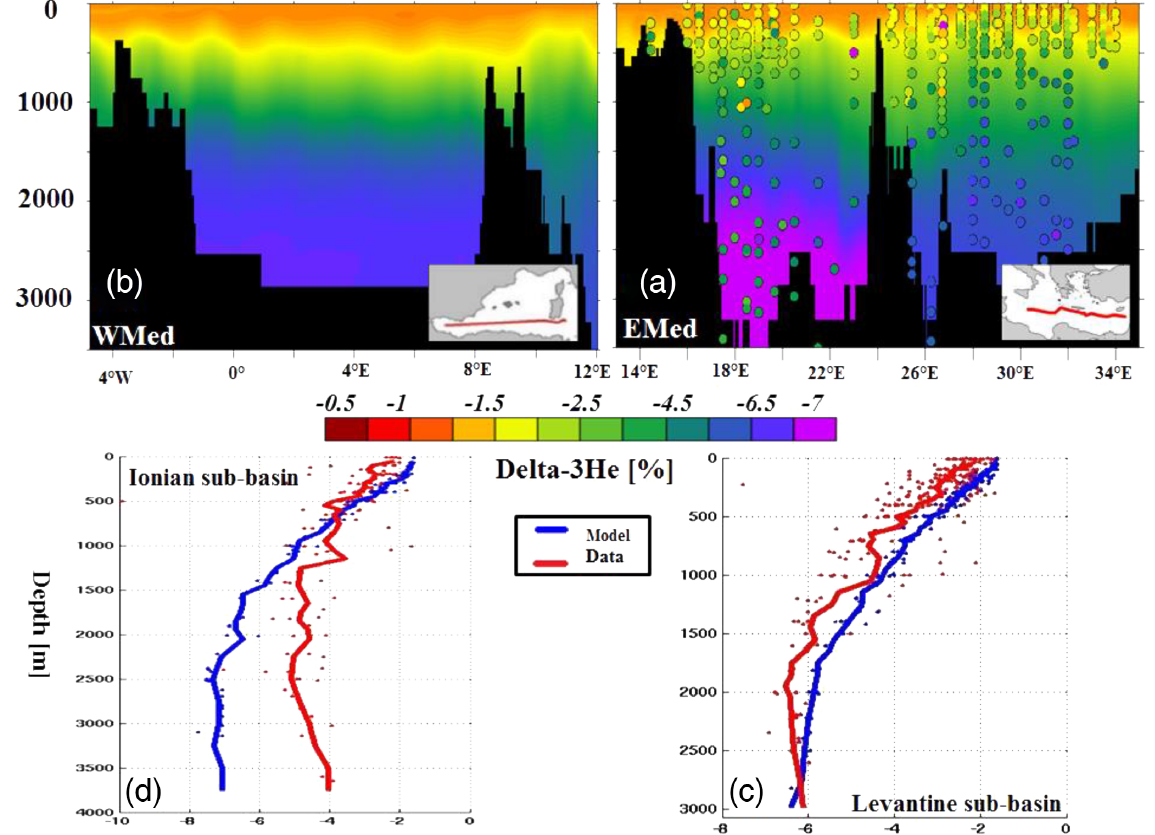
Figure 4. Crustal+atmospheric δ 3 He (in %) model–data comparison along the Meteor M5 (September 1987) section: (a) Colour-filled contours indicate simulated δ 3 He (%), whereas colour-filled dots represent the crustal + atmospheric δ 3 He deduced from in situ observations using the component separation method of Roether et al. (1998) in the eastern basin (see Sect. 4 for details). (b) : same as (a) , but in the western basin (WMed). There are no quantitative data for comparison in the WMed. (c) and (d) : comparison of average vertical profiles along the Meteor M5/9-1987 section for the Levantine and Ionian sub-basins, respectively; model results are in blue; red indicates the in situ